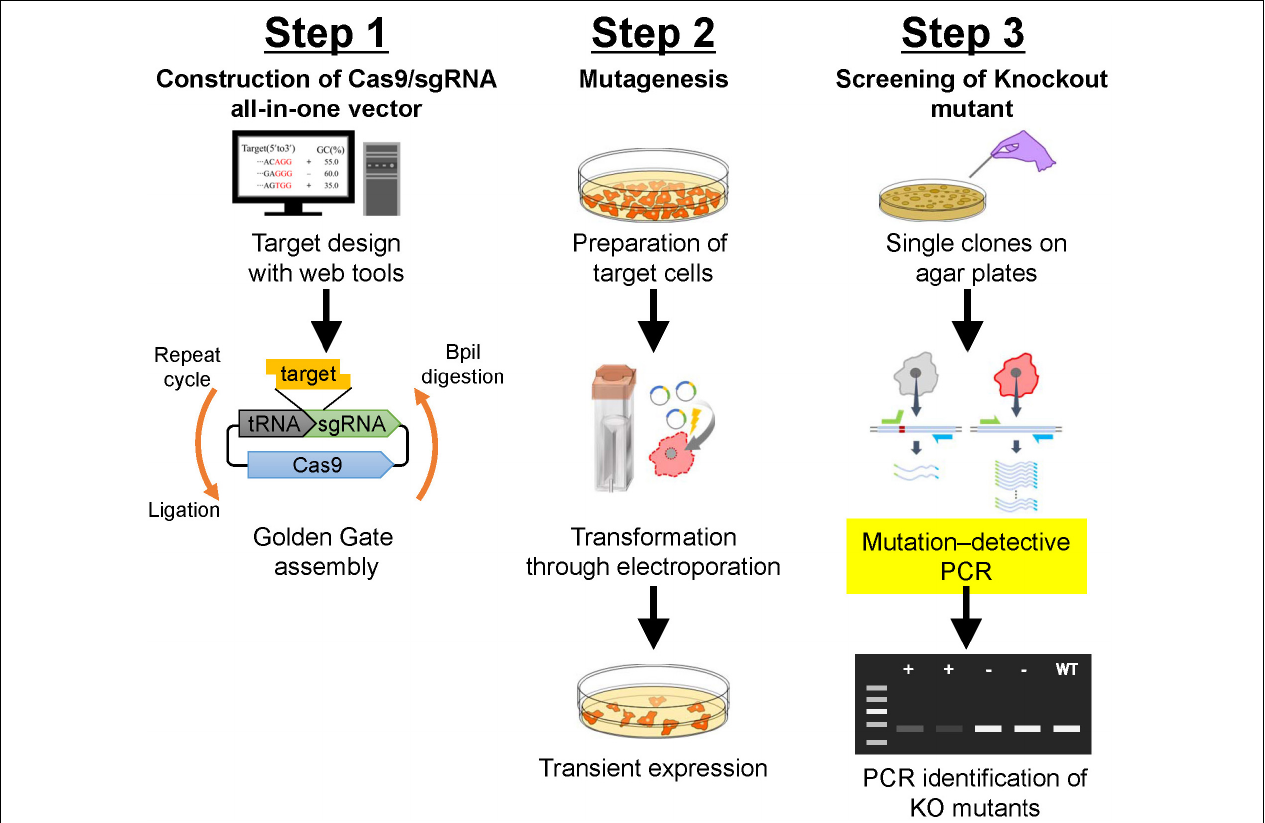
FIGURE 1 | Schematic description of gene manipulation in Dictyostelium using CRISPR/Cas9. Step 1 : Construction of CRISPR/Cas9 vector using Golden Gate assembly. Correctly integrated clones are selected using colony PCR followed by Sanger sequencing. Step 2 : Transformation of Dictyostelium cells. Electroporation is used to transform Dictyostelium . Transient expression of CRISPR/Cas9 vector is induced via the addition of a small amount of antibiotics. Step 3 : Screening of knock-out mutants. After isolation of individual colonies, mutation–detective PCR is conducted to identify positive knock-out mutants. For further validation of the mutation, genomic sequencing of the mutated region is